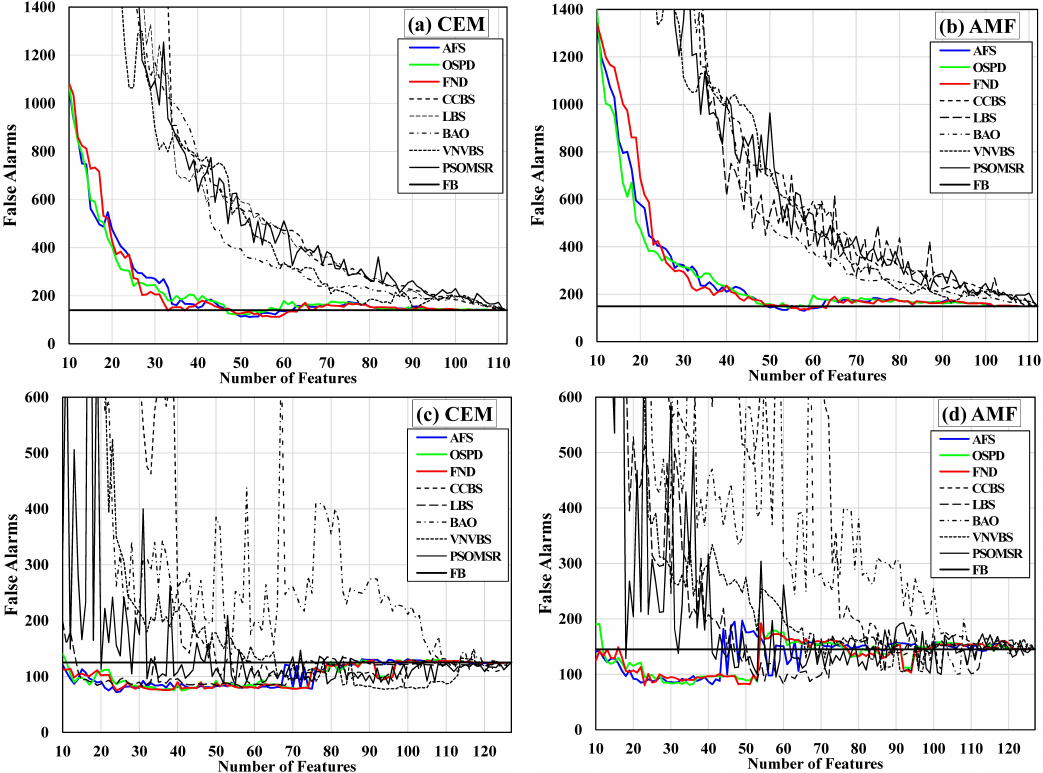
Figure 10. The number of false alarm (FA) pixels produced by the constrained energy minimization (CEM) and adaptive matched filter (AMF) detectors using feature subsets selected by different feature selection (FS) methods. Figure ( a , b ) are the results for the HyMap dataset and figure ( c , d ) show the results for the SIM.GA dataset. The curves in solid color lines are generated by the proposed FS methods. The black horizontal line in each figure indicates the full-band (FB) result for comparison with FS-based results.